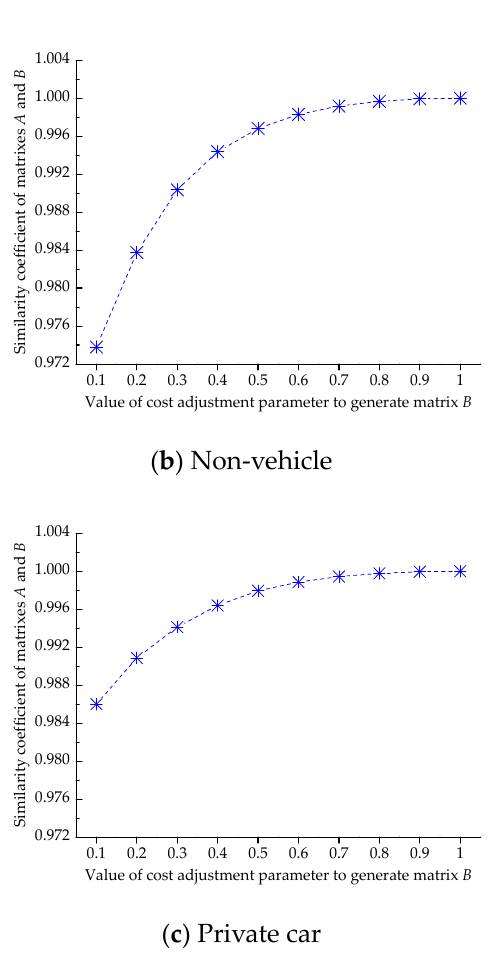
Figure 4. Similarity coefficient versus different cost adjustment parameters in three trip modes.